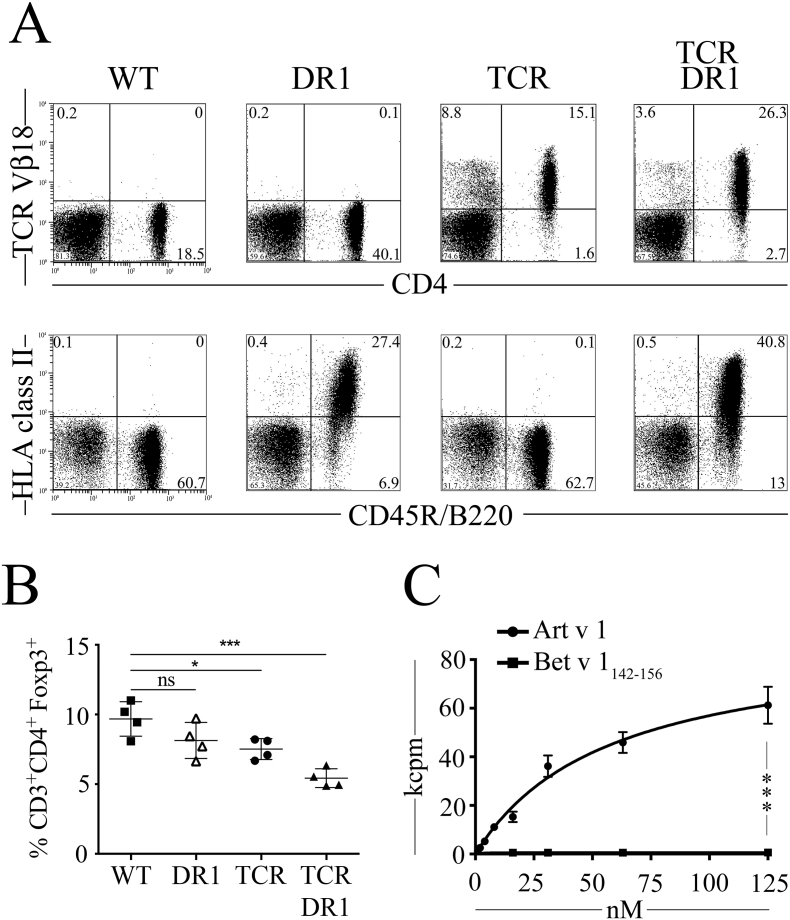
Expression and function of chimeric Art v 1-specific TCR and HLA-DR1. A, Flow cytometry analysis of TCR Vβ18 and HLA-DR1 expression on CD4+ and CD45R/B220+ PB lymphocytes isolated from WT, DR1, TCR and TCR-DR1 mice. Markers indicate negative control mAbs, numbers show percentage of cells. n = 4 per group of four analyses. B, Percentages of CD3+CD4+Foxp3+ cells in lymph nodes of WT, DR1, TCR and TCR-DR1 mice. Symbols represent individual mice. C, Dose dependent proliferation of TCR-DR1 splenocytes upon incubation with rArt v 1-protein, or Bet v 1142–153-peptide (negative control). kcpm, kilo counts per minute of incorporated [3H]-thymidine. Shown are representative SEMs of triplicate cultures of one out of four independent experiments. ***p < .001, Kruskal-Wallis test and Mann-Whitney-U test followed by post hoc Bonferroni correction.